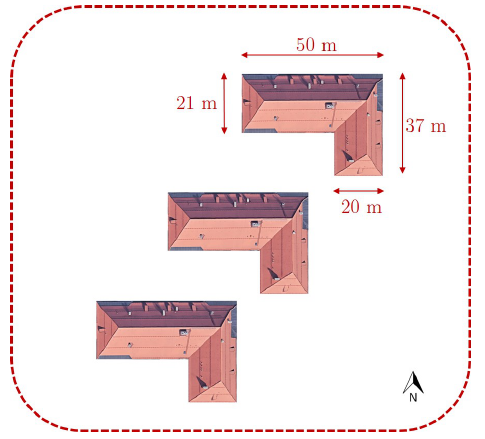
Figure 1. Assumed neighborhood with building dimensions (picture detail from